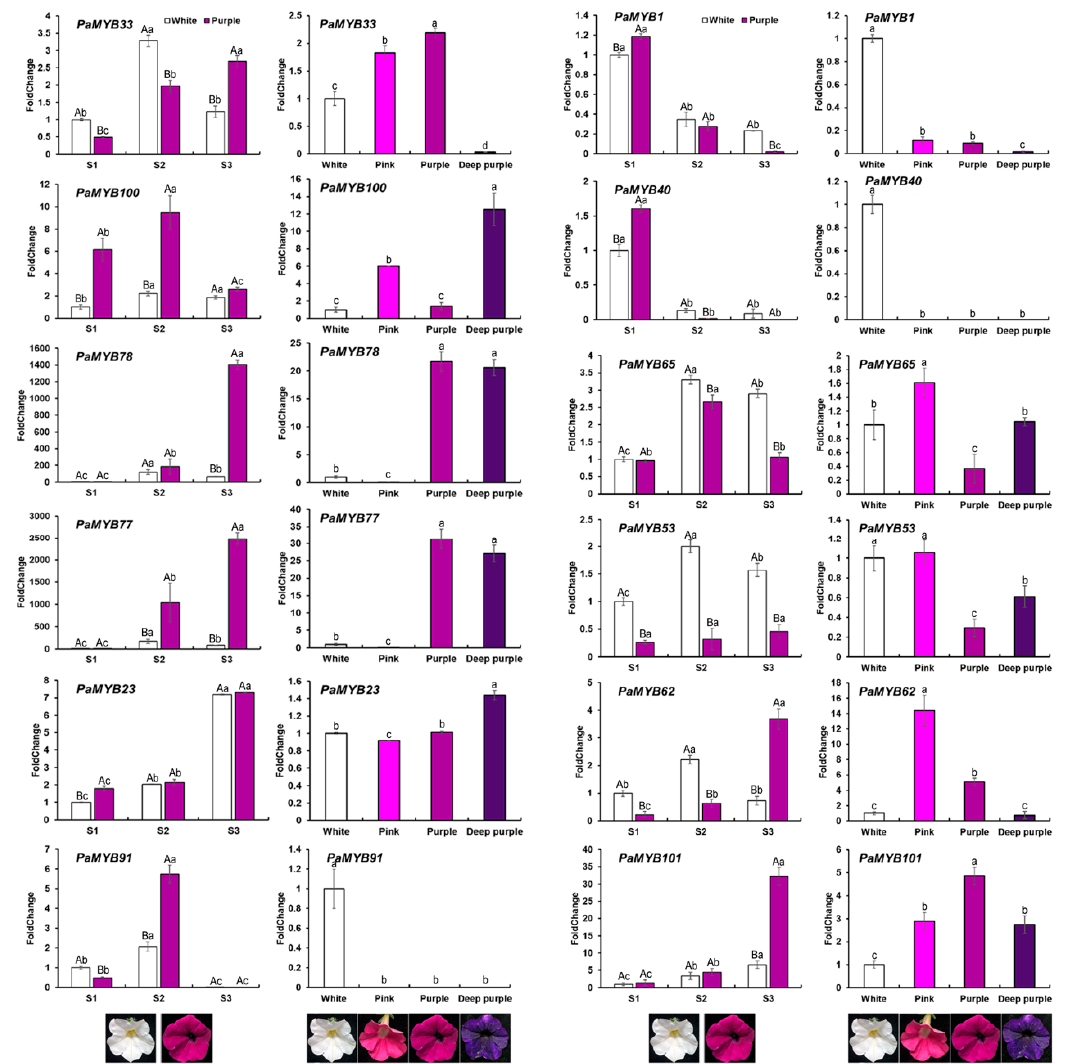
Figure 7. The significantly expressed MYB genes in Petunia in the pigmentation. The color of histogram represents the color of the petal. Each column represents the mean ± SE of three independent experiments each with three replicates. Different capitals indicate significant difference in the same stage. Different lowercases indicate significant difference in different stages.